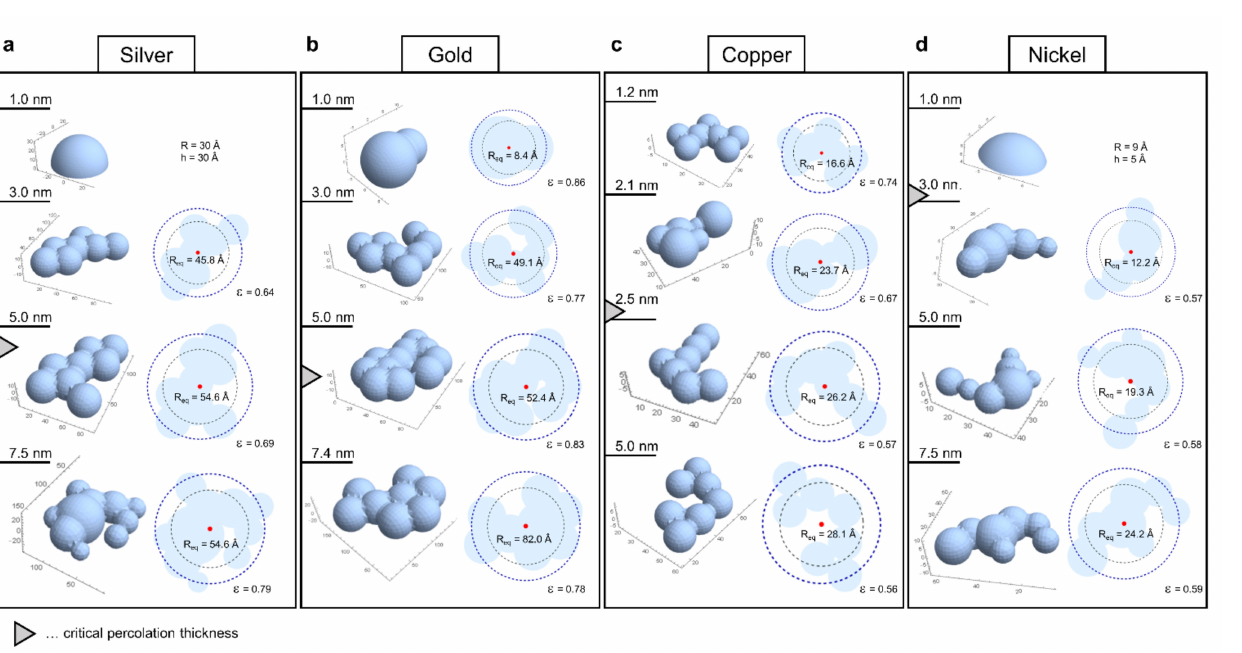
Figure 5. Approximated cluster geometries for GISAXS thin-film investigations of Silver ( a ), Gold ( b ), Copper ( c ) and Nickel ( d ). In each panel the cluster models are presented from top to bottom for successively thicker films as indicated on the left-hand side. The 3D representations of the estimated cluster geometries are shown left and the top down projections with the radius of gyration (R g , thin black dashed circles, value not shown) and the radius of a sphere with equivalent R g (R eq , thick blue dashed circles) are shown on the right side. ε is the ratio between cluster footprint area within the blue circle and the whole area within that circle and indicates the